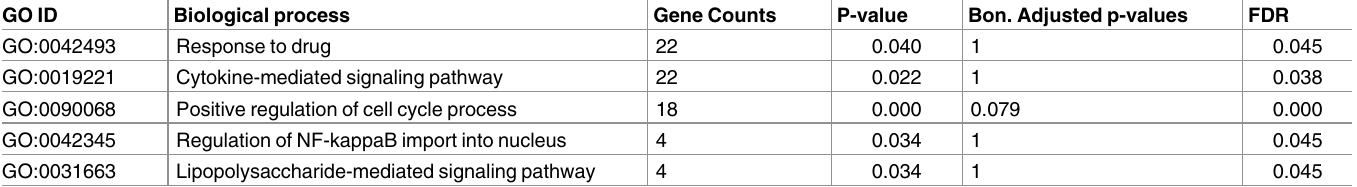
Table 3. Biological process GOs of Pietrain cluster 34 post PRRSV infection.